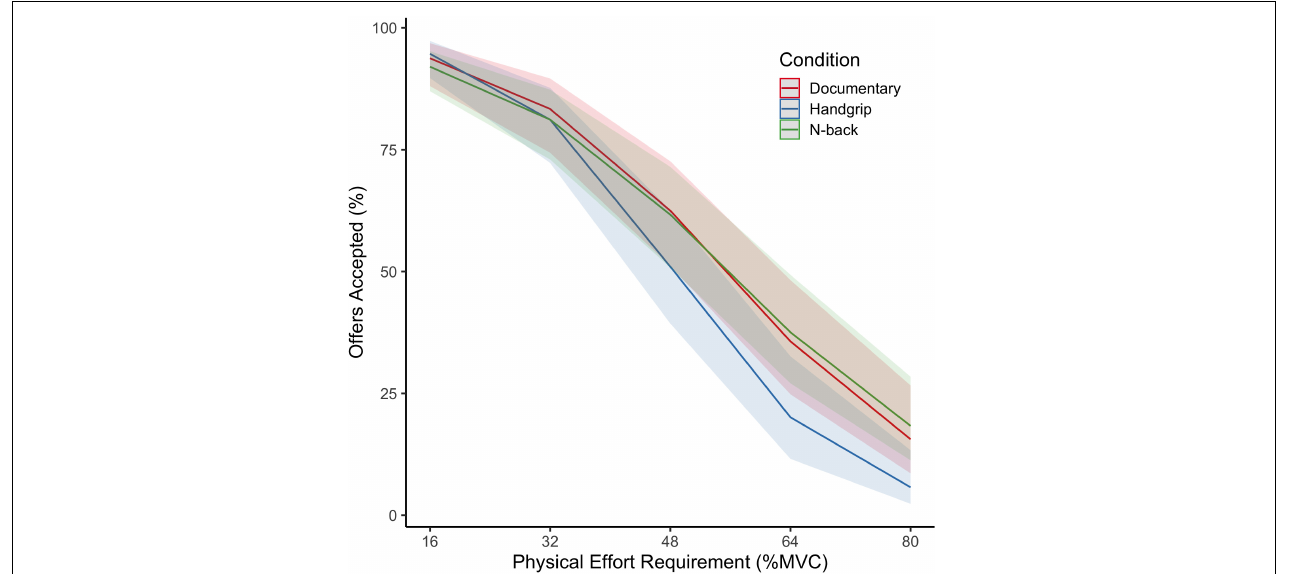
FIGURE 2 | Effects of physical effort requirements and condition on percentage of offers accepted. N = 20. MVC, Maximum Voluntary Contraction. Shaded areas represent 95% confidence intervals. The overall percentage of effortful offers accepted did not differ significantly between the experimental conditions. However, the effort slope was significantly steeper after performing the handgrip exercise than after documentary watching or after performing the N-back task. Between-condition comparisons at the specific levels of physical effort requirement did not reach significance.